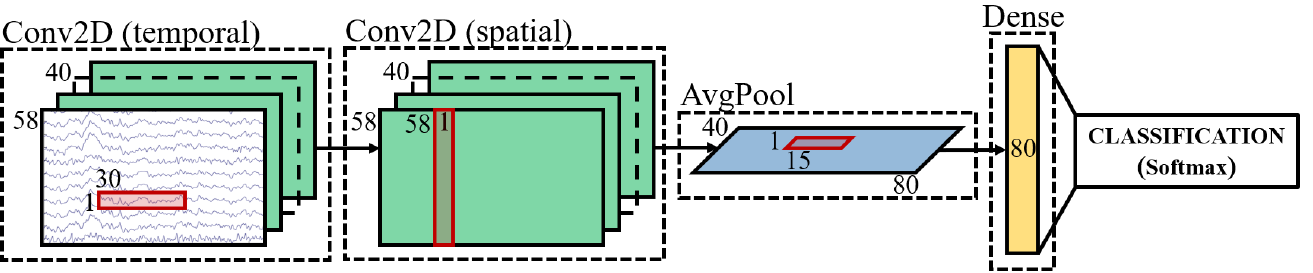
Figure 2. Schematic representation of the proposed CNN model architecture. The first two were convolutional layers: the first one performed a temporal filter- ing (i.e., convolution along the time axis), while the second one a spatial filtering (i.e., convolution along the channel axis). Each convolutional layer was followed by a batch normalization and an exponential linear unit (eLu) activation function. Then, an average pooling layer, which flattened the input to a single dimension, and two fully